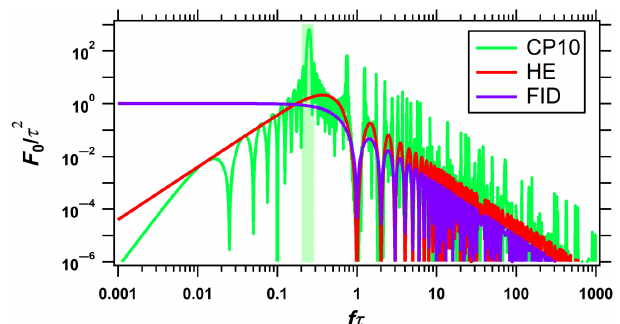
FIG. 3. Center lobe filter functions for CP10, HE, and FID experiments. The green highlighted region corresponds to the portion of the CP10 filter function used to infer the magnetic gradient noise